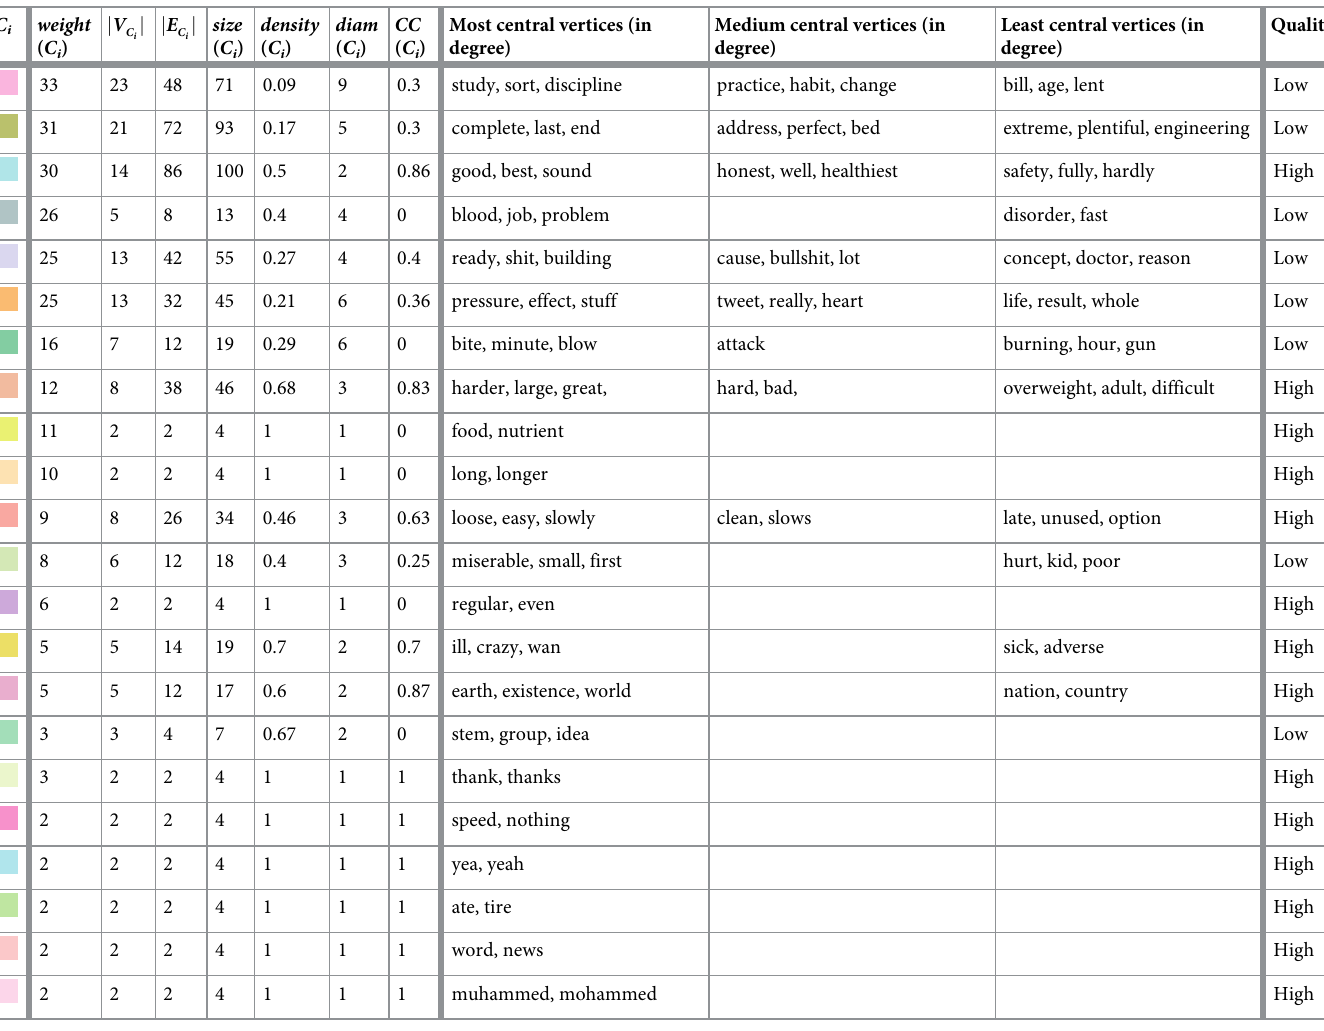
Table 2. Summary of the qualities of the 22 main communities in the text graph in Fig 3. C i weight ) ( C i